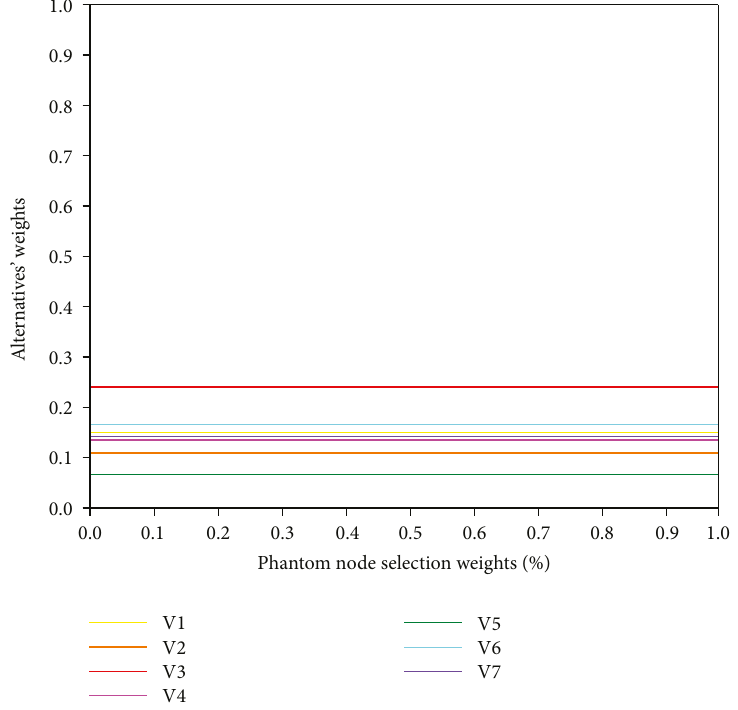
Figure 5: Scenario